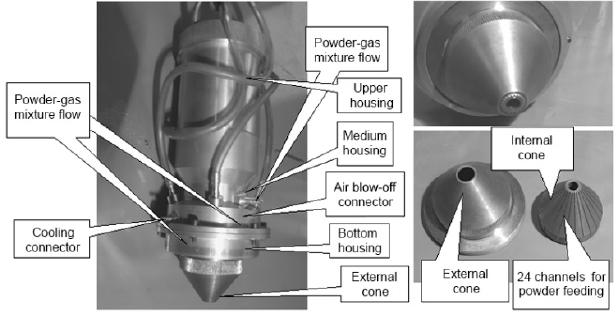
Figure 9. The principle scheme of laser lens.